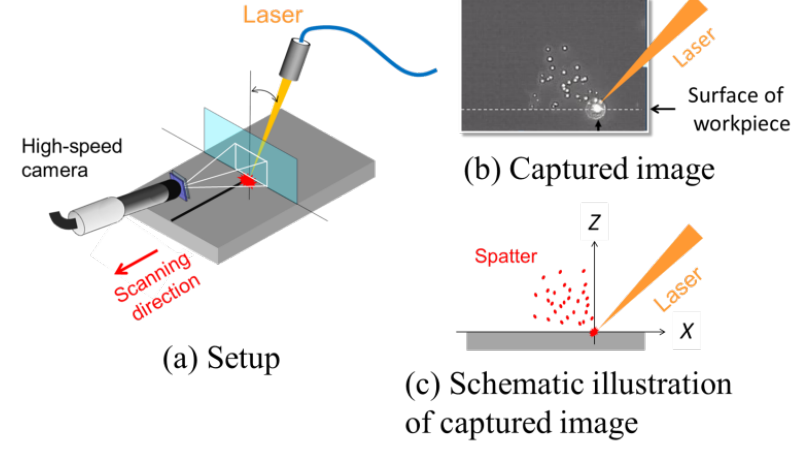
Figure 6. High-speed observation of spatter.